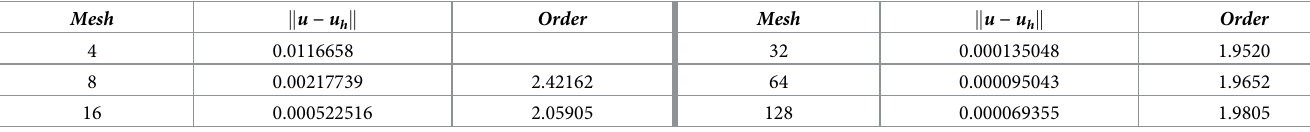
Table 3. Error profile and convergence rate for the Experiment 3.